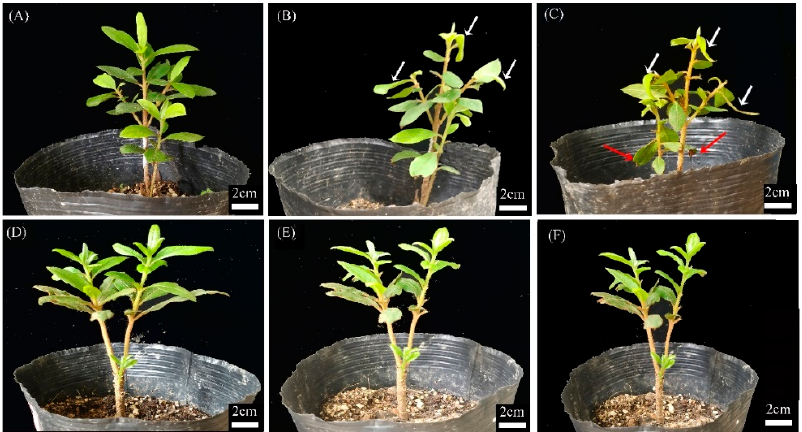
Figure 1. The phenotypes of the plants under the four treatments. ( A ) CK + W represents the control treatment with distilled water; ( B ) H + W represents the heat stress treatment after 1 day with distilled water; ( C ) H + W represents the heat stress treatment after 2 days with distilled water; ( D ) CK + Ca 2+ represents the control treatment with 10 mM CaCl 2 ; ( E ) H + Ca 2+ represents the heat stress treatment after 1 day with 10 mM CaCl 2 ; ( F ) H + Ca 2+ represents the heat stress treatment after 2 days with 10 mM CaCl 2 . Red arrow points to the leaves with burnt edge; white arrows point to the wilting